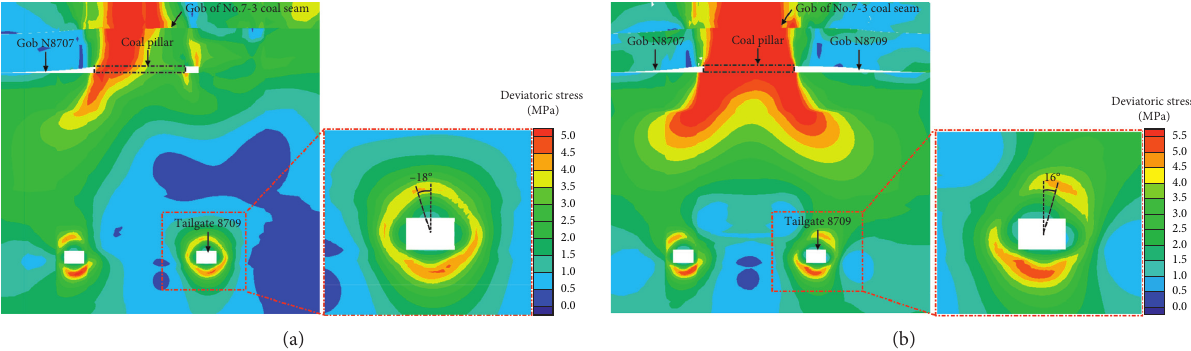
Figure 4: Nephograms of deviatoric stress after mining of N8707 and N8709 coal faces in No. 7-4 coal seam: (a) nephogram of deviatoric stress after mining of the N8707 coal face in No. 7-4 coal seam; (b) nephogram of deviatoric stress after mining of the N8709 coal face in No. 7-4 coal